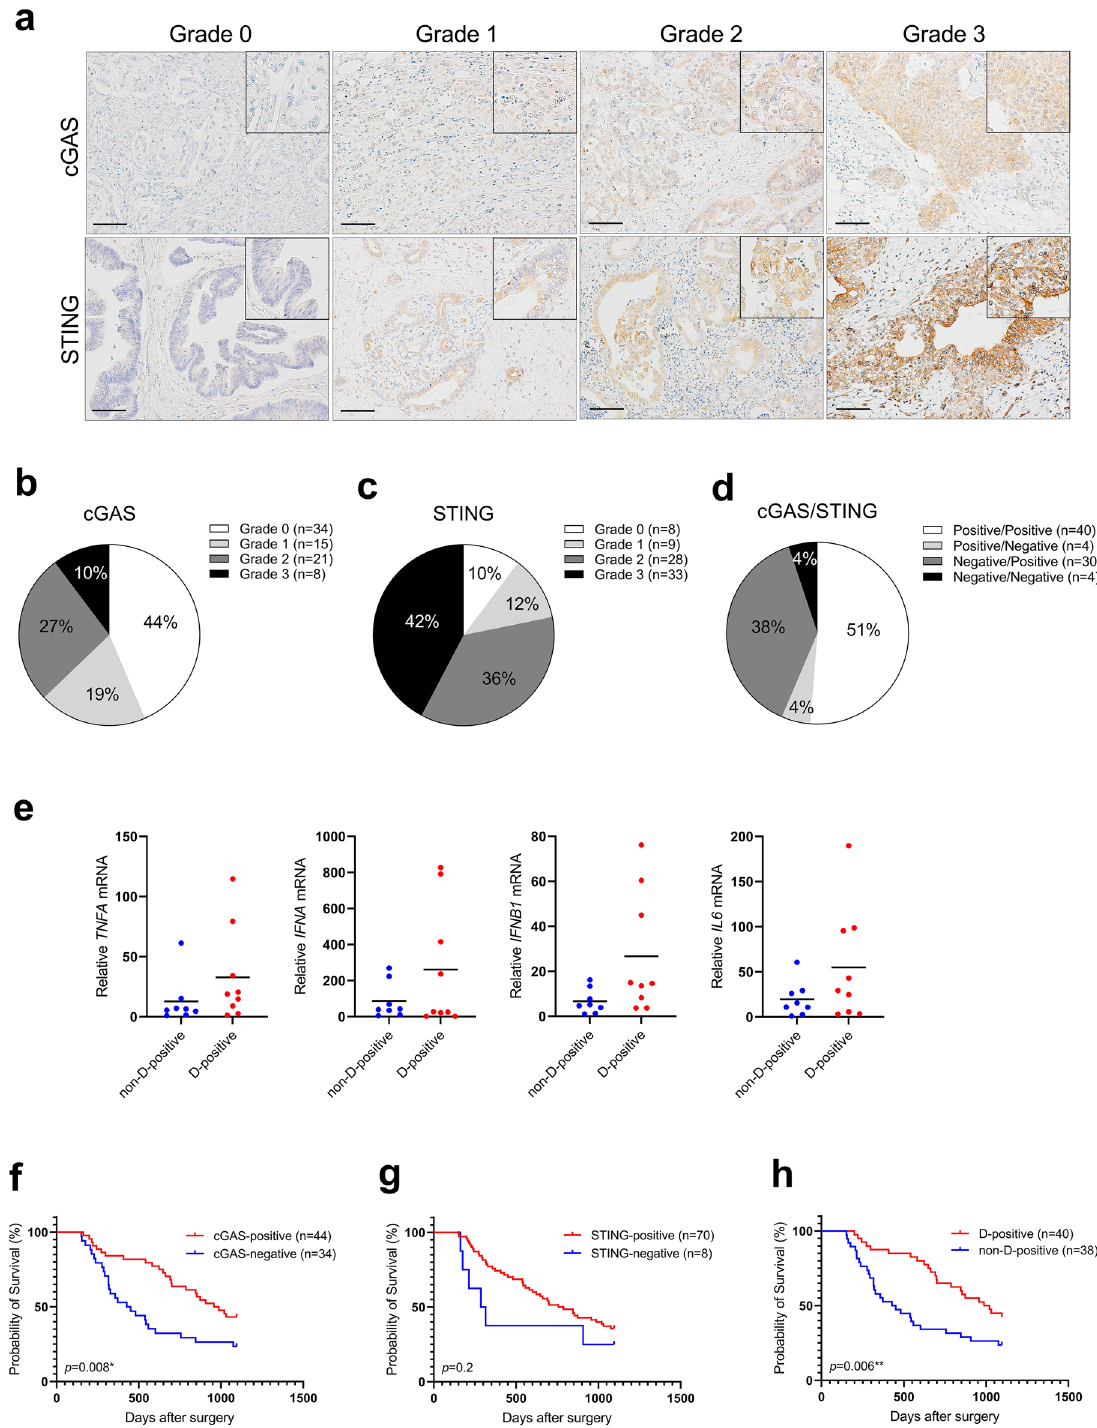
Figure 1. Downregulation of cGAS-STING expression correlates with poor prognosis in PDACs. ( a ) The representative immunohistochemical staining of cGAS and STING in each expression grade. ( b ) Percentage of each cGAS expression grade in 78 PDAC cases. ( c ) Percentage of each STING expression grade in 78 PDAC cases. ( d ) Percentage of cGAS/STING expression in each case. cGAS and STING double positive as Positive/ Positive; only cGAS positive as Positive/Negative; only STING positive as Negative/Positive; and both negative as Negative/Negative. ( e ) qPCR analysis for target genes of cGAS-STING pathway in cGAS-STING double-positive (D-positive) cases vs other cases (non-D-positive); including cGAS or STING single-positive, or double-negative. ( f ) Kaplan–Meier analysis in cGAS-positive (Grade 1, 2, 3) cases vs cGAS-negative (Grade 0) cases. ( g ) Kaplan– Meier analysis in STING-positive (Grade 1, 2, 3) cases vs STING-negative (Grade 0) cases. ( h ) Kaplan–Meier analysis in D-positive cases vs non-D-positive cases. Scale bar: 100 µm. ** p < 0.01, * p < 0.1. Statistical significance in the Kaplan–Meier analysis was determined using the log-rank test. This figure was created using GraphPad Prism 9.3.0 (https:// www. graph pad. com/ scien tific- softw are/